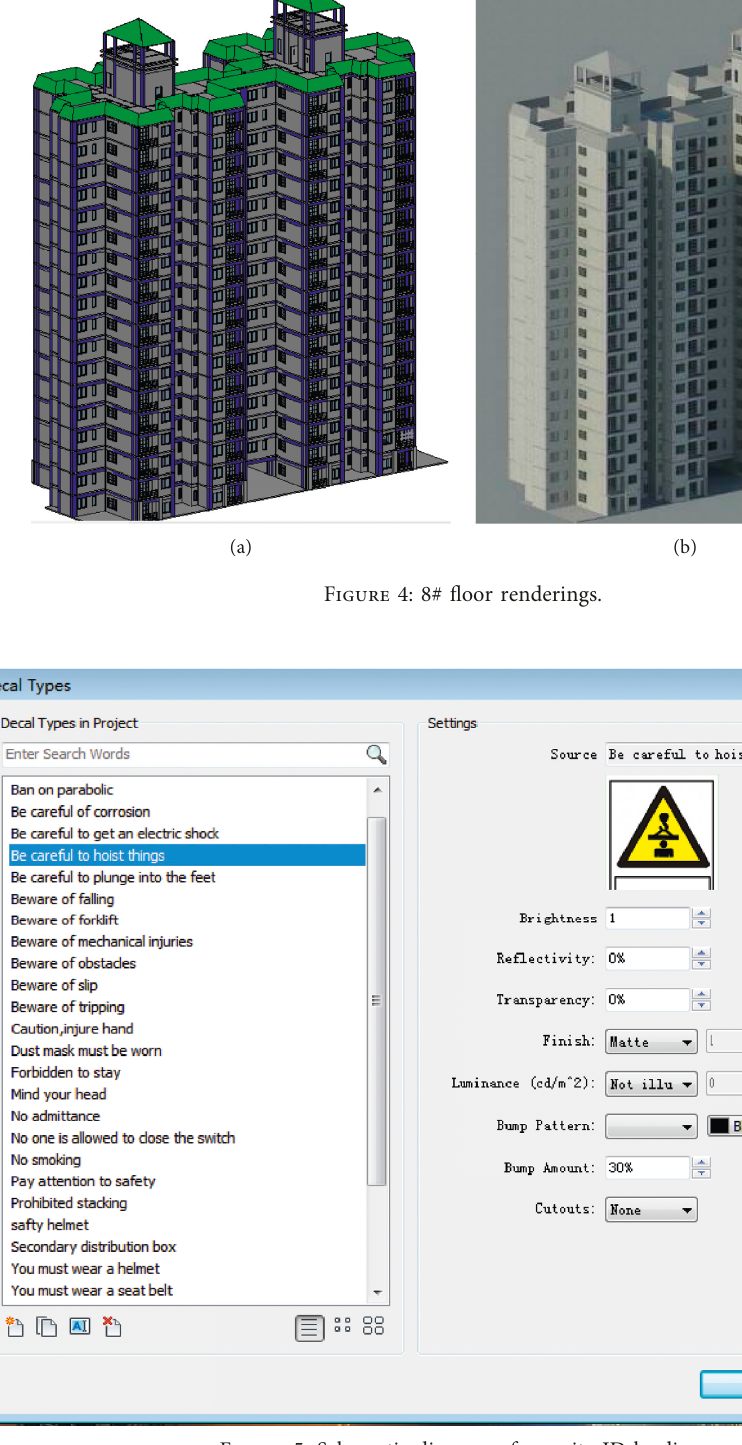
Figure 5: Schematic diagram of security ID loading.